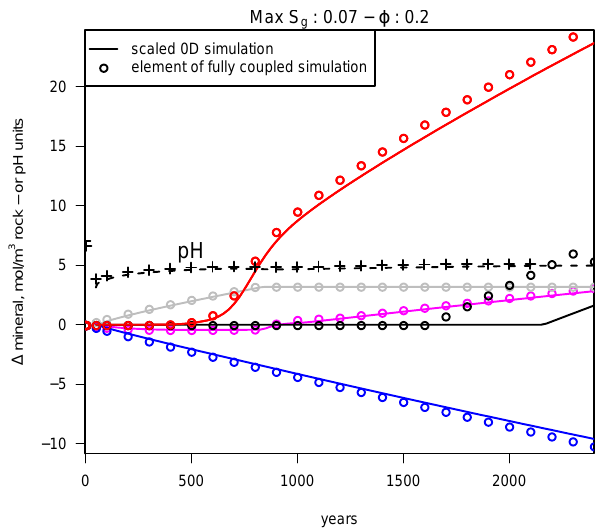
Figure 7. Comparison between the mineral changes in one element of the heterogeneous case with weak similarity (52.26). This el- ement has only been exposed to dissolved CO 2 . Even with such a high value of the similarity function, the difference between the precipitated carbonates at the end of simulation time is below 10%. A numerical measure of the self-similarity is needed in or- der to control the initial hypothesis. This is achieved compar- ing the mineral changes in each element to the 0-D reference simulation. Noted with (cid:49)M i , the changes of a mineral M (in mass unit per m 3 rock) at the time steps i = 1 ,...,N from the fully coupled simulations and with (cid:49)M ∗ the changes i from the reference model (after translation of its time axis to match the arrival time of CO 2 in the element), the similar- ity is defined as the average quadratic relative error over the time